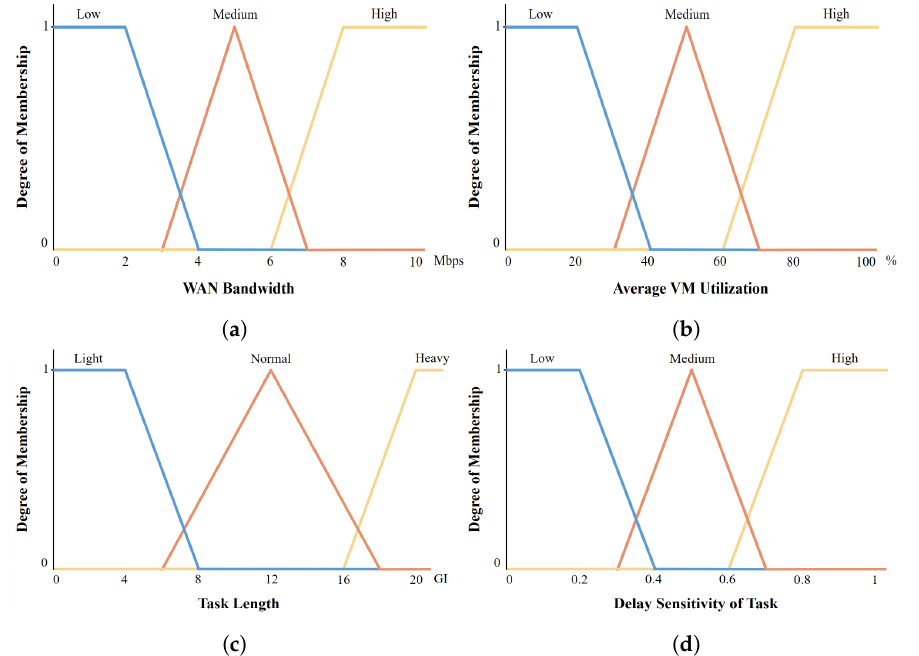
Figure 7. Set of membership functions for each input variable in the second FLS: ( a ) WAN bandwidth. ( b ) Average VM utilization. ( c ) Task length. ( d ) Delay sensitivity of the